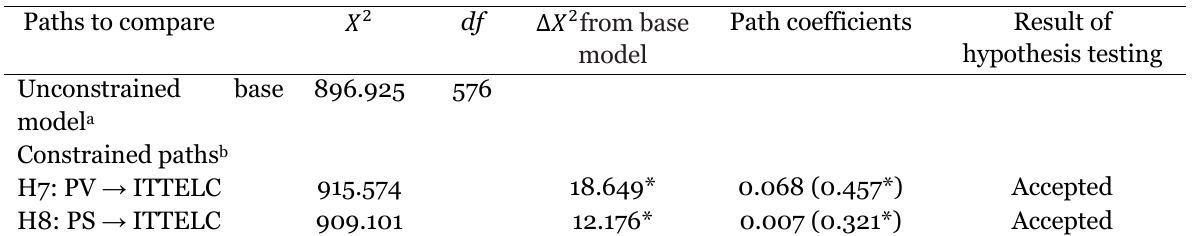
Table 9 Multigroup Analysis of Paths from PV and PS to ITTELC Between Taiwan and Vietnam Paths to compare 𝑋 2 df ∆𝑋 2 from base Path coefficients Result of hypothesis testing model Unconstrained base 896.925 576 model a Constrained paths